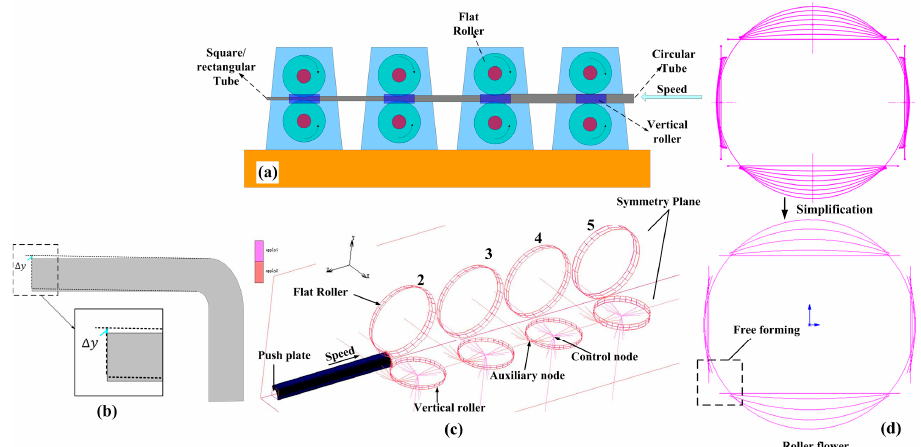
Figure 6. Finite element model of the roll forming. ( a ) Schematic diagram of rolling forming; ( b ) Evaluation index of springback calculation; ( c ) Finite element model; ( d ) Roller flower. Table 3. Process parameters of the roll forming.